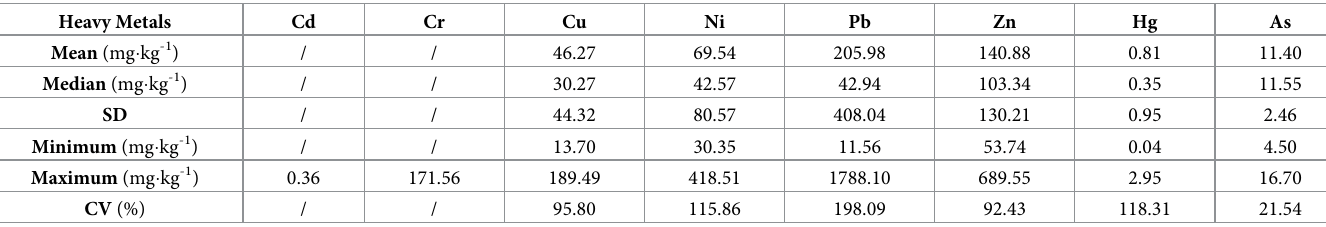
Table 6. Descriptive statistics of heavy metal concentrations at 26 sample